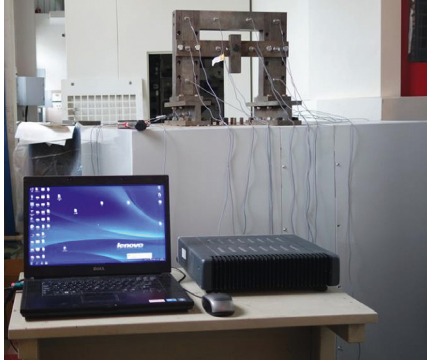
Figure 6: Dynamic analysis test